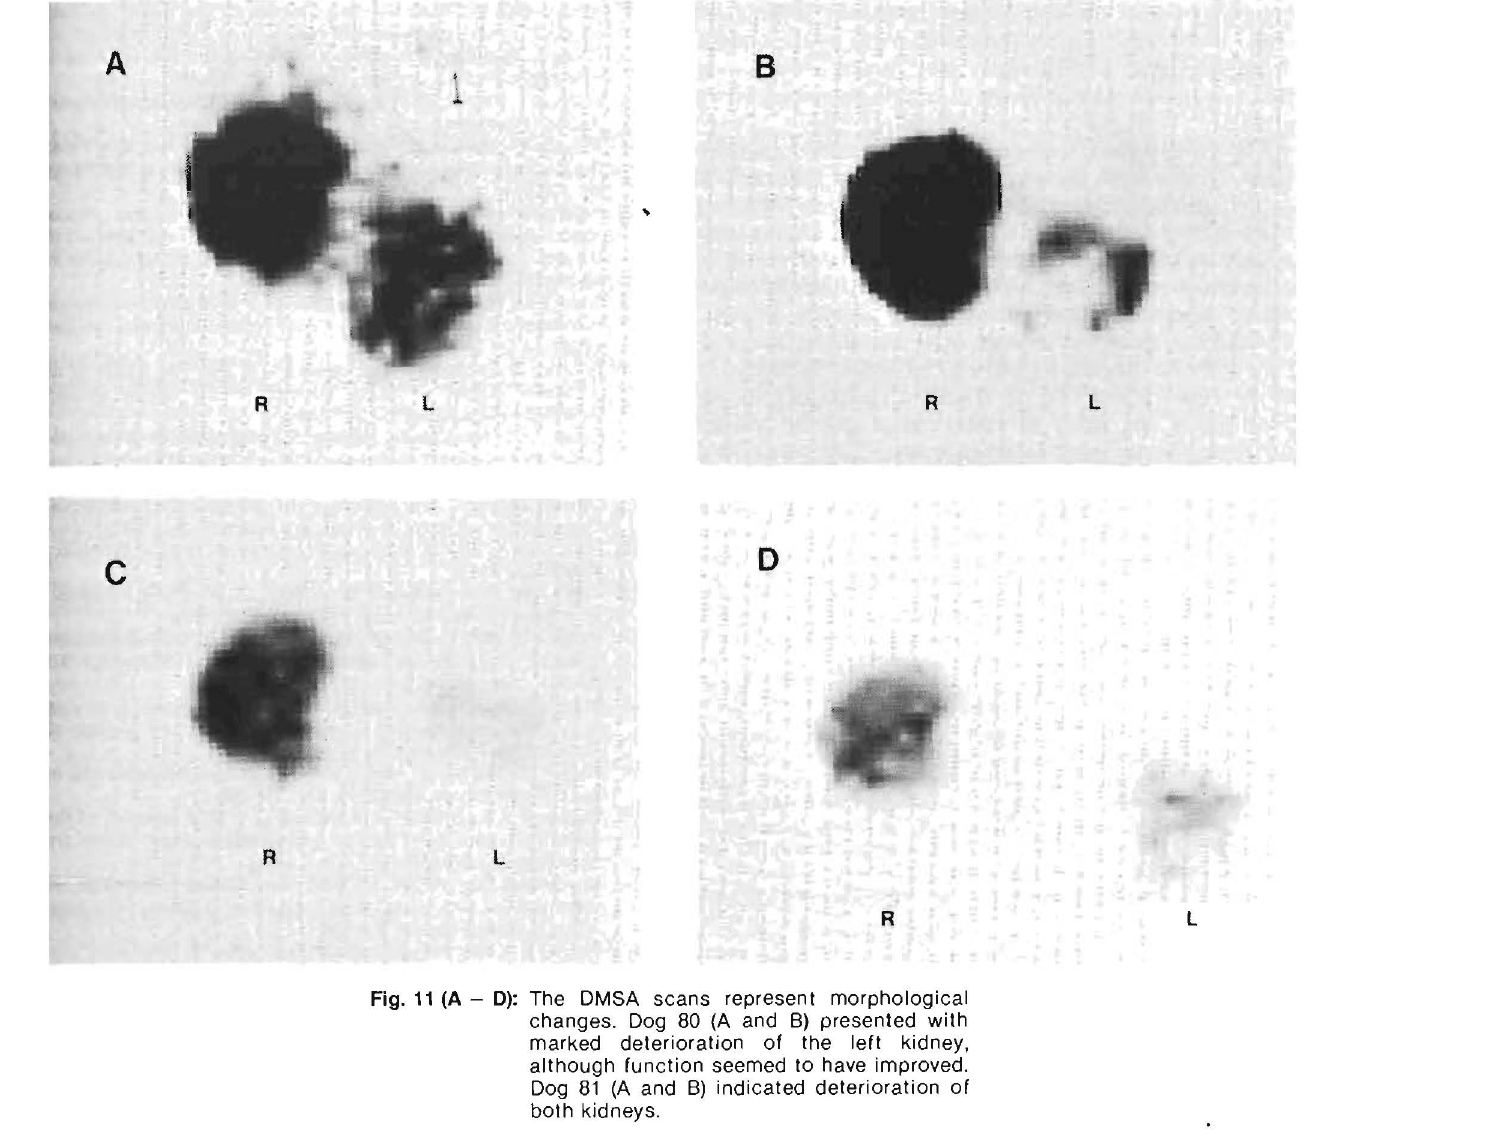
Fig. 11 (A - 0): The DMSA scans represent morphological changes. Dog 80 (A and 8) presented with marked deterioration of the left kidney, although function seemed to have improved. Dog 81 (A and 8) indicated deterioration of both